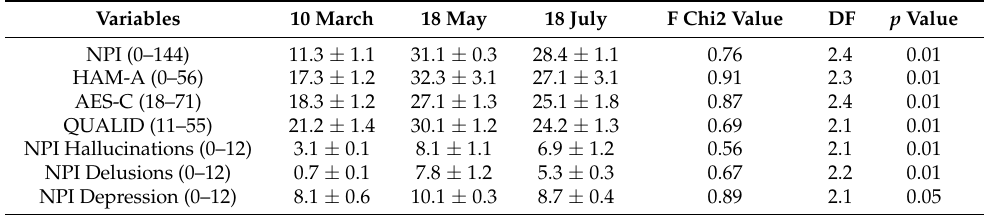
Table 4. Comparison of mean value and SD of the defined neuropsychological scores in Group A.